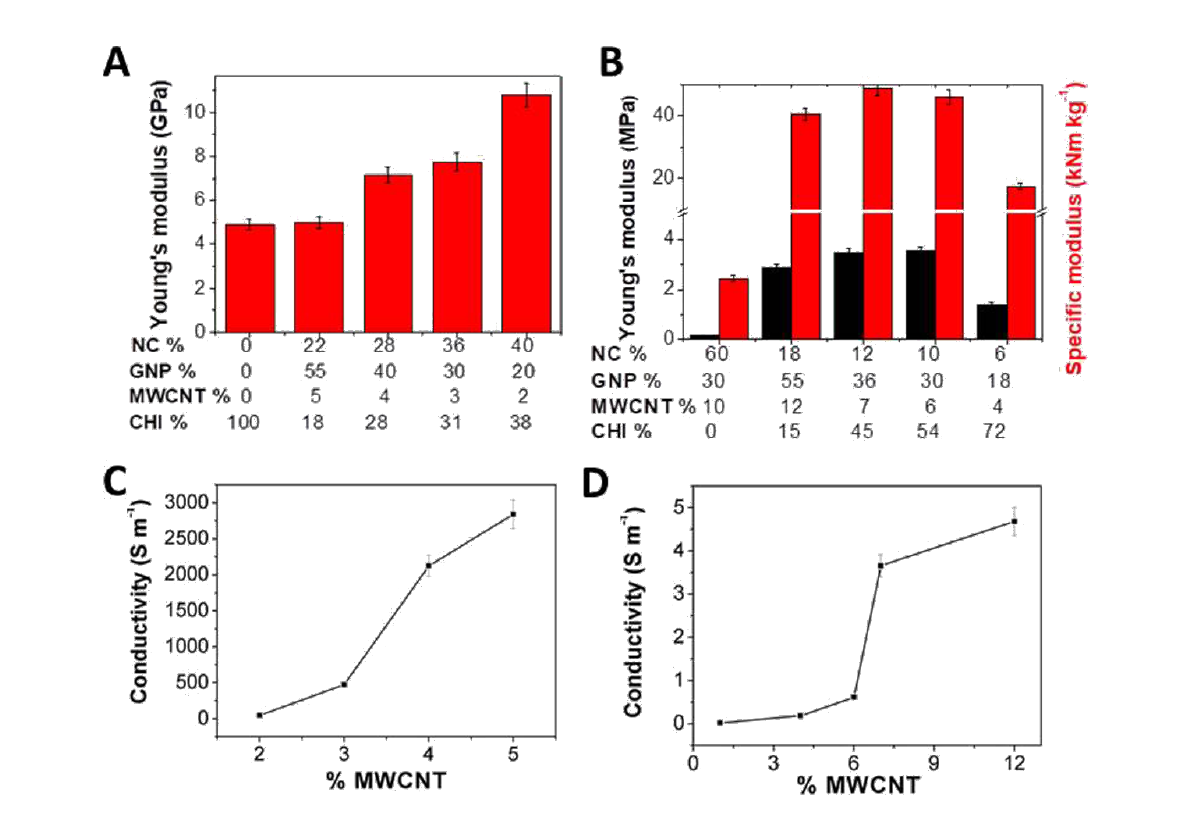
Figure 4: Young’s moduli and electrical conductivity of HNTs/SEP/GNPs/MWCNTs/CHI films (A, C) and foams (B, D), respectively.